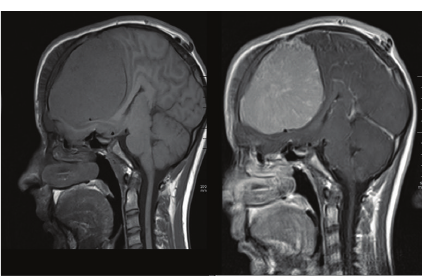
Figure 2: Magnetic resonance imaging. Contrast-enhanced sagittal T1-weighted MRI scan shows an extra-axial frontal tumoral lesion with intense enhancement.